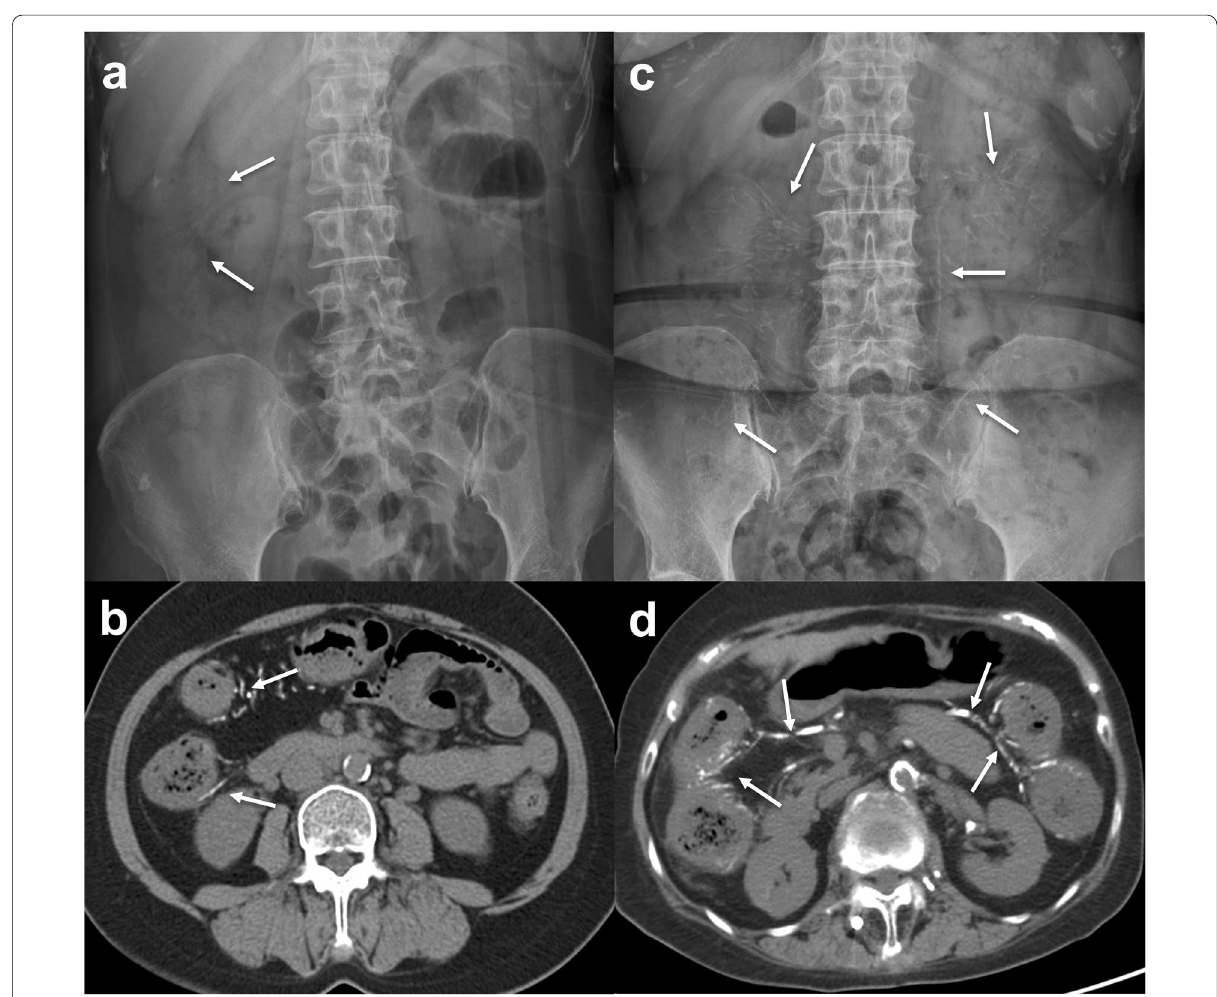
Fig. 4 A 58‑year‑old woman with hepatitis B and chronic renal failure initially presented with mild right abdominal discomfort. a , b Plain radiograph and abdominal CT show curvilinear calcifications (arrows) alongside the distal ascending colon. c , d Mild abdominal pain and intermittent tarry stool noted for 11 years and follow‑up radiograph and CT show progression of PC with calcification of superior and inferior mesenteric venous branches (arrows) and colonic wall thickening extending to distal descending